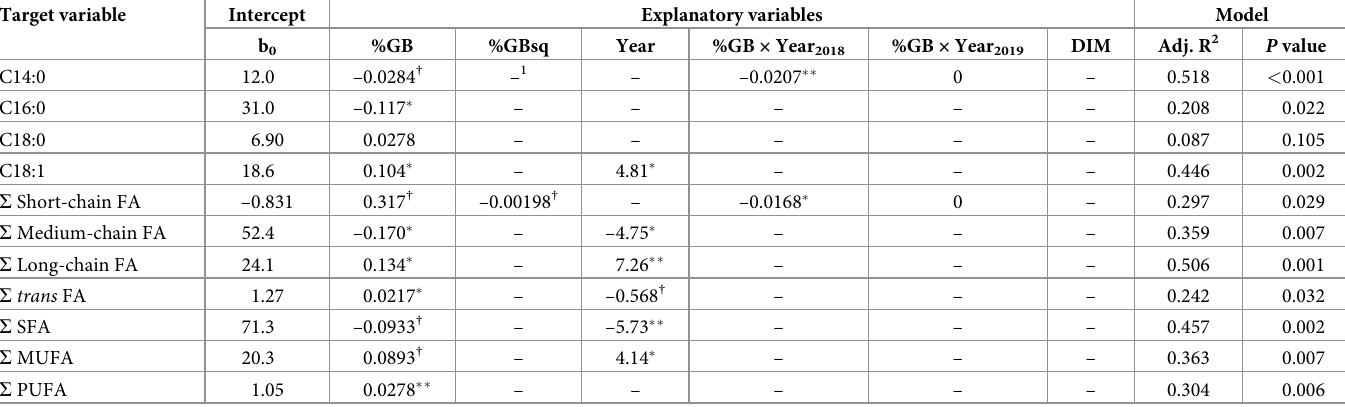
Table 6. Regression coefficients for proportions of individual fatty acids (FA) and groups of FA (g/100g total FA) in milk estimated by MIR in relation to the per- centage of grassland-based feeds in the diet (%GB) and the year of harvest (n = 10, 2018; n = 11, 2019). Target